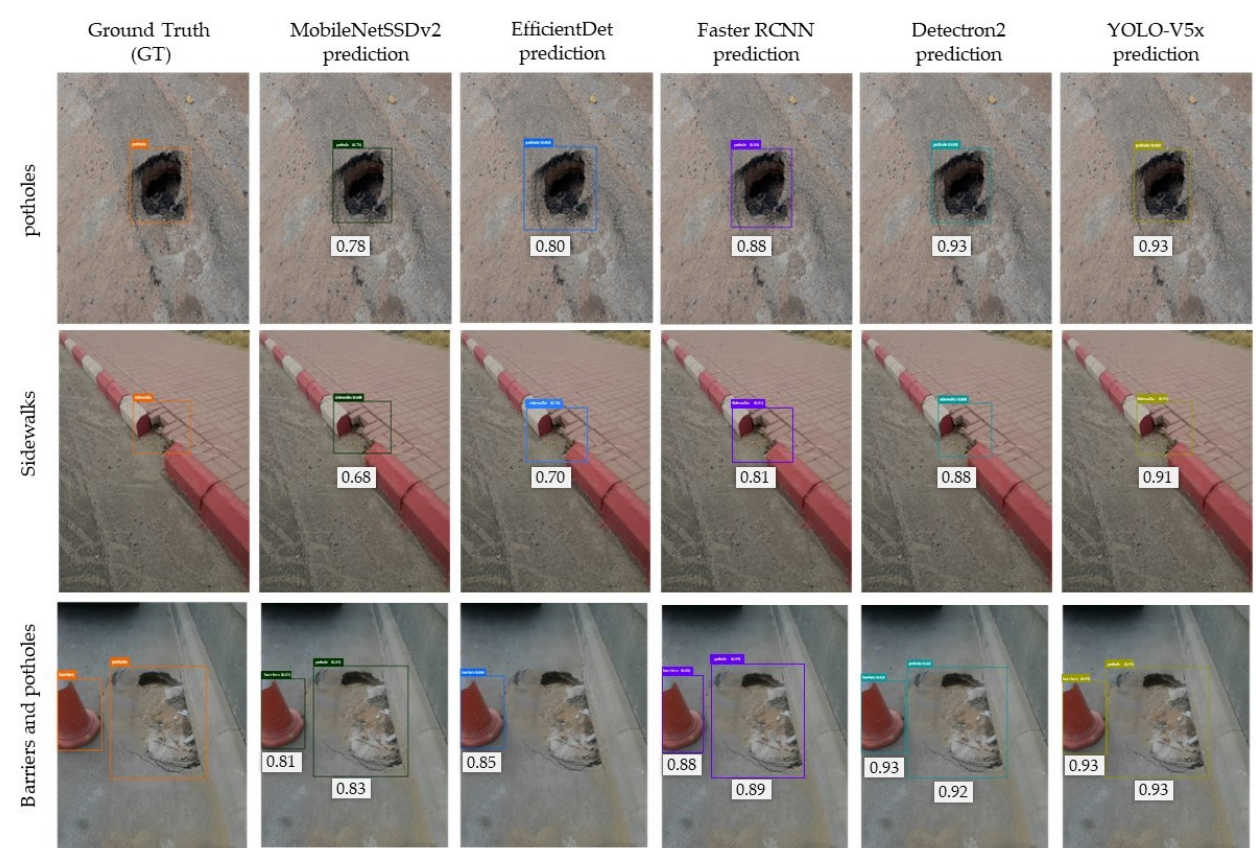
Figure 18. Qualitative evaluation results of the proposed VPP framework for VP detection and classification using AI predictors: MobileNetSSDv2, EfficientDet, Faster RCNN, Detectron2, and YOLO. The prediction object surrounding the box with its confidence score is superimposed on the original image for each AI predictor. The confidence score or classification probability is highlighted inside a small white box besides a detected object.